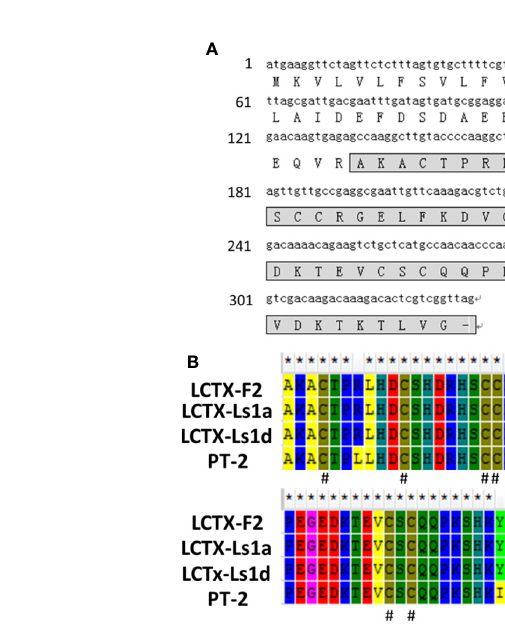
FIGURE 1 | Amino acid and cDNA sequence of LCTX-F2. (A) The cDNA sequence of LCTX-F2. The sequence of mature LCTX-F2 is boxed and the stop codon is indicated by a bar ( – ). (B) NCBI-BLAST sequence alignment of LCTX-F2 with other homologs. Identical amino acid residues are indicated by the symbol (*). Cysteine residues are indicated by the symbol (#)